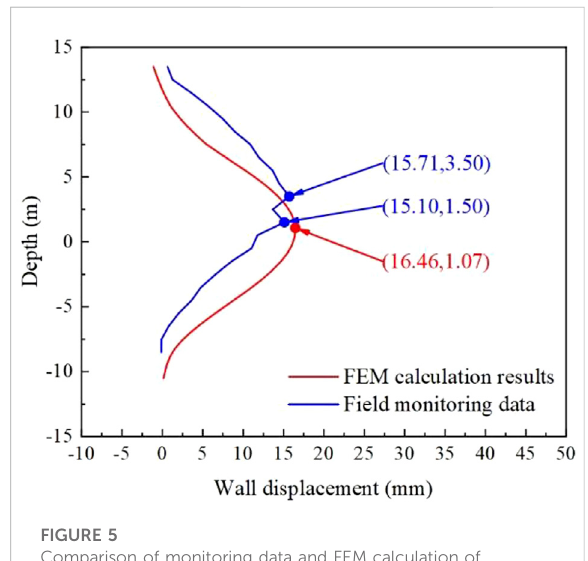
FIGURE 5 Comparison of monitoring data and FEM calculation of horizontal displacement of the diaphragm